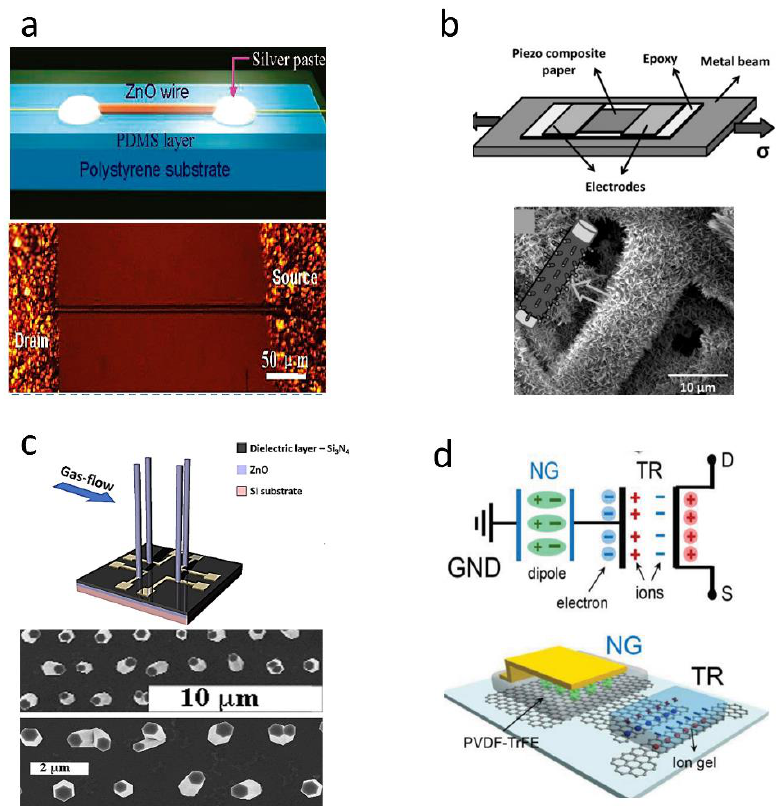
Figure 7. Sensors based on piezotronics effect. ( a ) strain sensor based on individual ZnO piezoelectric fine-wires: structural schematic diagram (upper part) and SEM image (lower part). Copyright from ACS. ( b ) strain sensor based on ZnO-paper: structural schematic diagram (upper part) and SEM image (lower part). Copyright from John Wiley and Sons. ( c ) sensor based on individually contacted vertical piezoelectric nanowires: structural schematic diagram (upper part) and SEM image (lower part). Copyright from Elsevier. ( d ) transistor with P(VDF-TrFE) as active materials and graphene as gate electrodes: circuit diagram (upper part) and structural schematic diagram (lower part). Copyright from John Wiley and Sons.